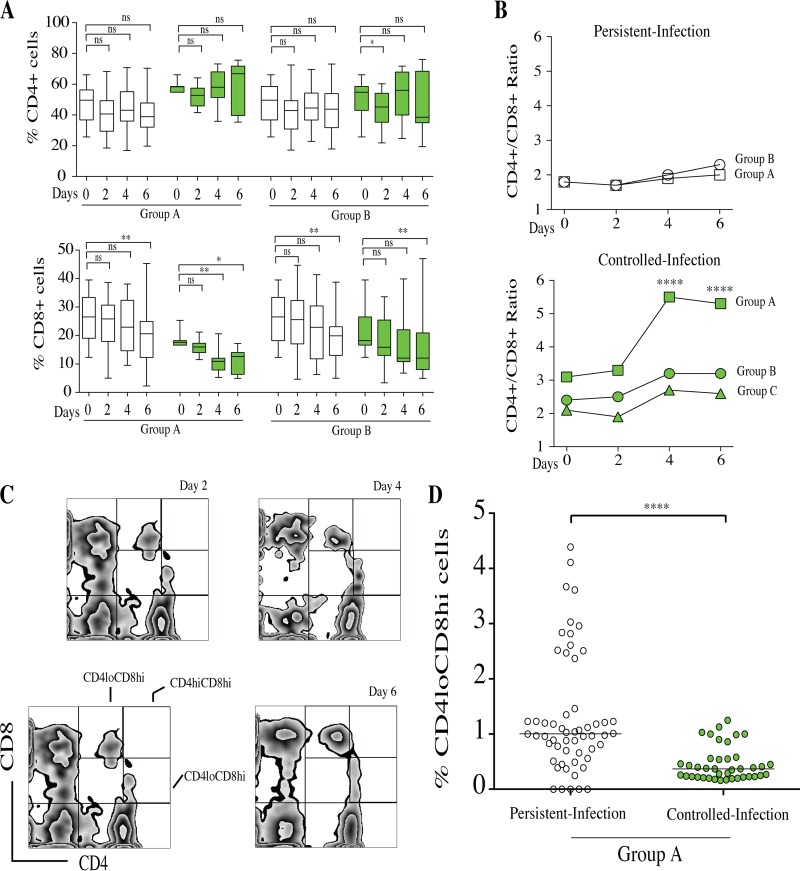
Characterization of CD4+ CD8+ doubly positive T cells within Candida granuloma-like structures from group A over time. (A) Proportions of CD4+ and CD8+ cells within granuloma-like structures are expressed as percentages of the total CD3+ compartment. Box plots depict median, minimum, and maximum percentages of CD4+ and CD8+ cells over time according to infection status (persistent [white boxes] and controlled [green boxes]) and Candida groups. (B) Dynamics of CD4+/CD8+ ratio over time between persistent-infection and controlled-infection granuloma-like structures. (C) Representative flow cytometry analysis showing CD4+ and CD8+ cells after gating on CD3+ lymphocytes. CD4lo CD8hi, CD4hi CD8hi, and CD4hi CD8lo cells were analyzed in the upper right quadrant. (D) The proportions of CD4lo CD8hi cells within granuloma-like structures are expressed as percentage of the total CD4+ CD8+ doubly positive T cell compartment. *, P < 0.05; **, P < 0.001; ***, P < 0.0001; ****, P < 0.00001 (by one-way ANOVA with Tukey's multiple-comparison test) (n = 120).